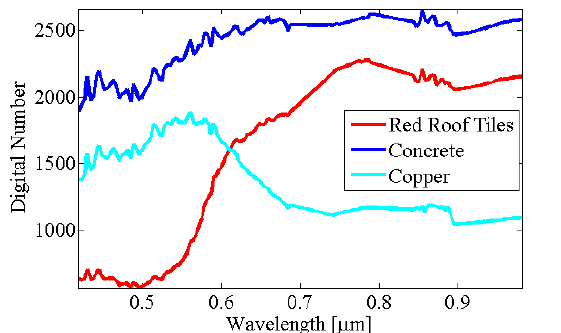
Figure 1: Spectral signatures of three roofing materials.